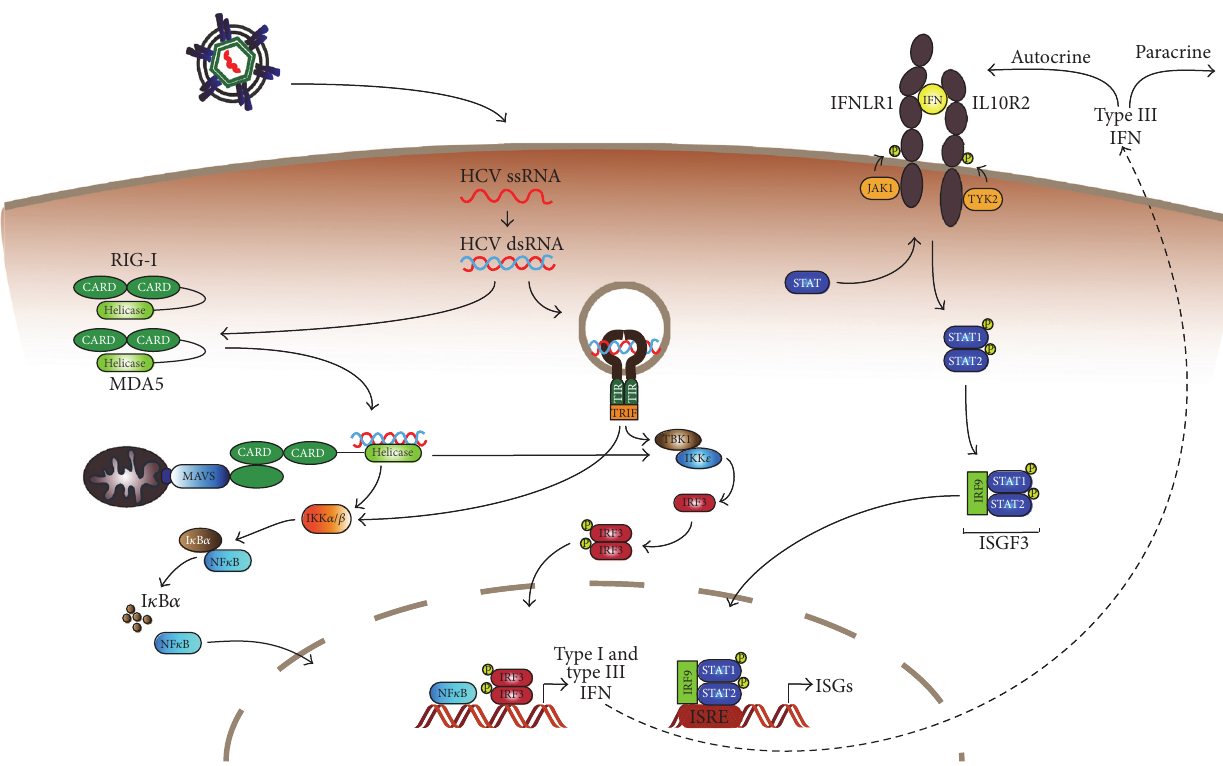
Figure 3: Innate immunity against HCV. In HCV infected cells dsRNA replication intermediates are recognized by the cytosolic RNA sensors RIG-I and MDA5, leading to the activation of MAVS. Endosomal dsRNA is recognized by TLR3, leading to the activation of TRIF. MAVS and TRIF signal via the kinases IKK and TBK1, resulting in translocation of the transcription factors NF- 𝜅 B and IRF3 to the nucleus. Here they trigger the expression of type I and type III IFNs, which are secreted and bind to their receptors in an auto- or paracrine manner. Subsequently, the JAK/STAT pathway is activated, which ultimately initiates the expression of ISGs, generating an antiviral